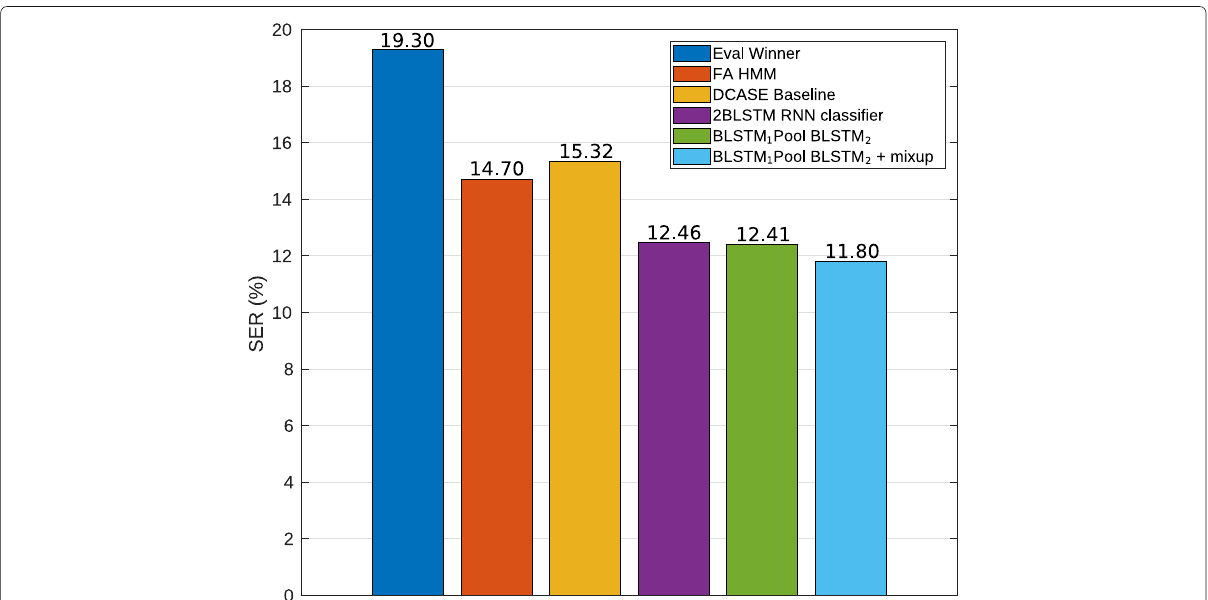
Fig. 7 Results obtained on the Albayzín 2010 test partition for different systems proposed in the literature compared to our proposed RNN approaches in terms of SER